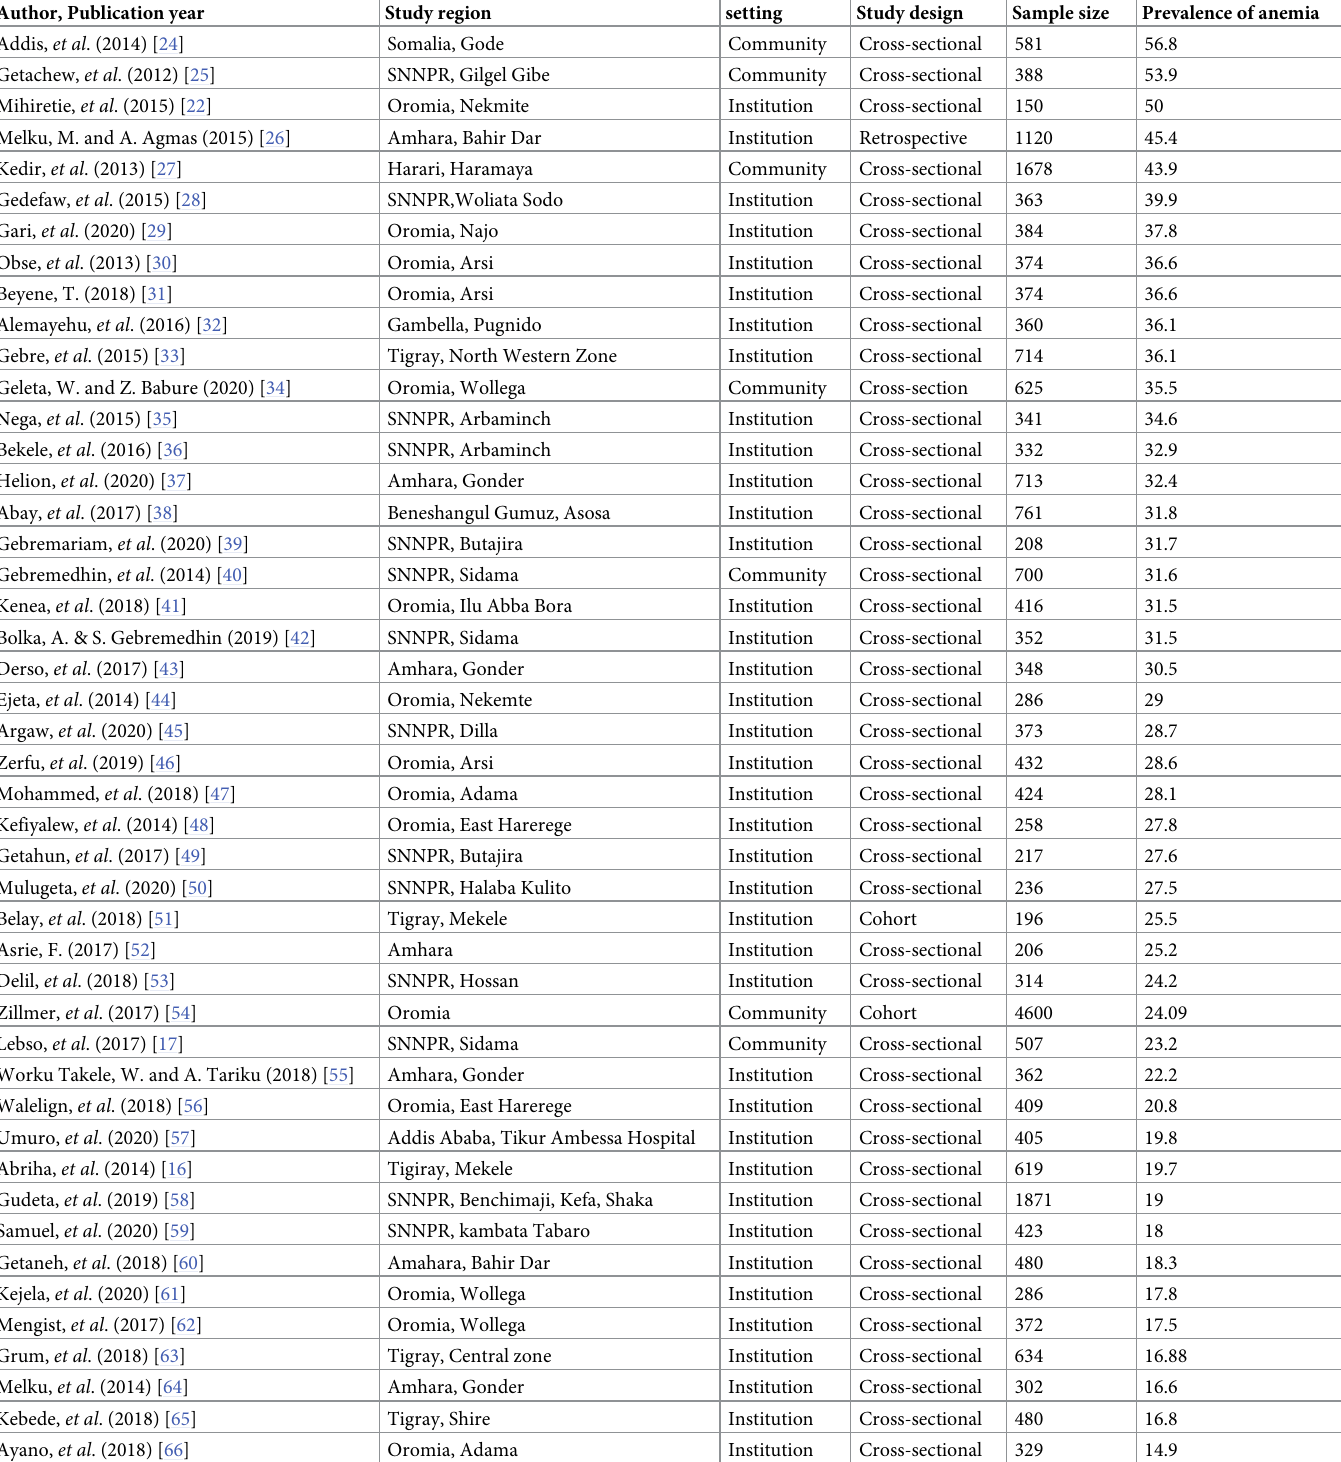
Table 1. Characteristics of studies included in the current systematic review and meta-analysis on prevalence and predictors of anemia among pregnant women in Ethiopia,